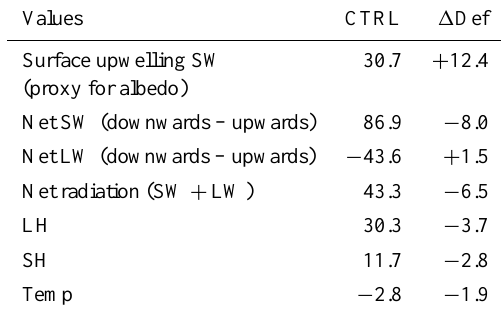
Table 6. The annual surface energy balance averaged over land cells north of 45 ◦ N over the last 20yr of the MPI-ESM boreal deforesta- tion experiment. Values for the experiments are given as deviations of boreal deforestation experiment ( 1 Def) from the control cli- mate (CTRL). All fluxes are in Wm − 2 , surface temperature in ◦ C. SW=shortwave radiation; LW=longwave radiation; LH=surface upwards latent heat flux; SH=surface upwards sensible heat flux; Temp=near-surface air